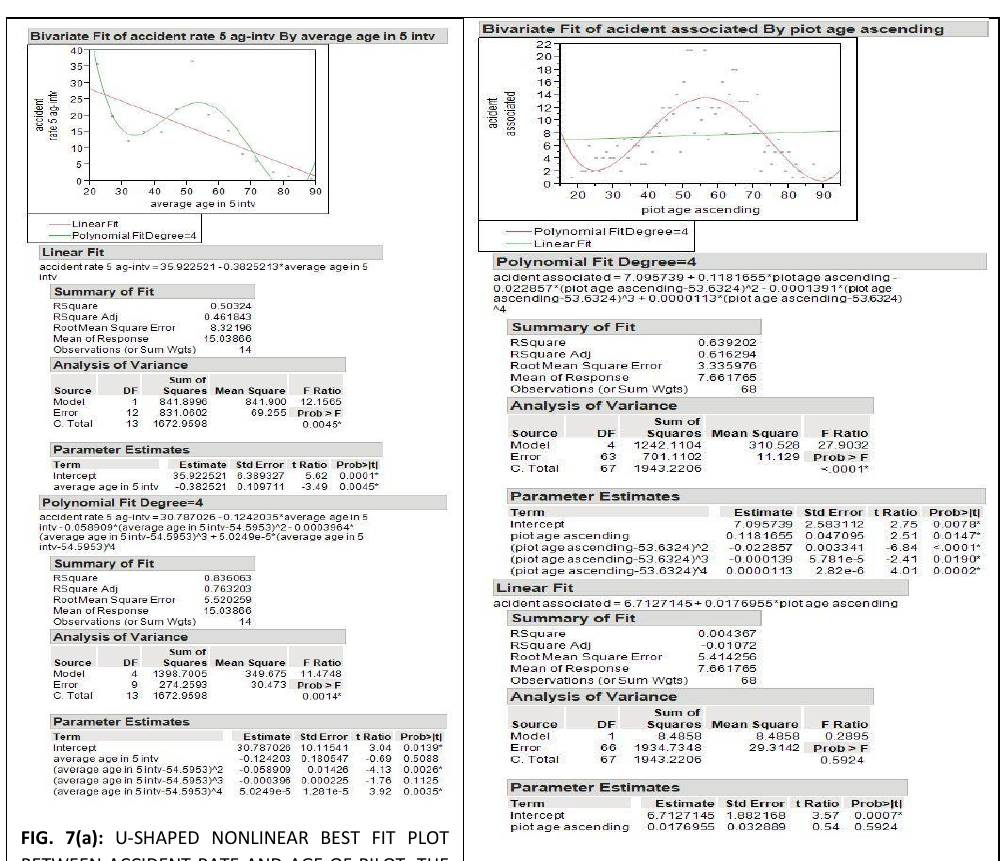
FIG. 7(b) : BEST FIT PLOT BETWEEN THE NUMBER OF ACCIDENTS AND PILOT AGE THE ACCIDENTS ARE CONSIDERED AS FUNCTION OF FLYING